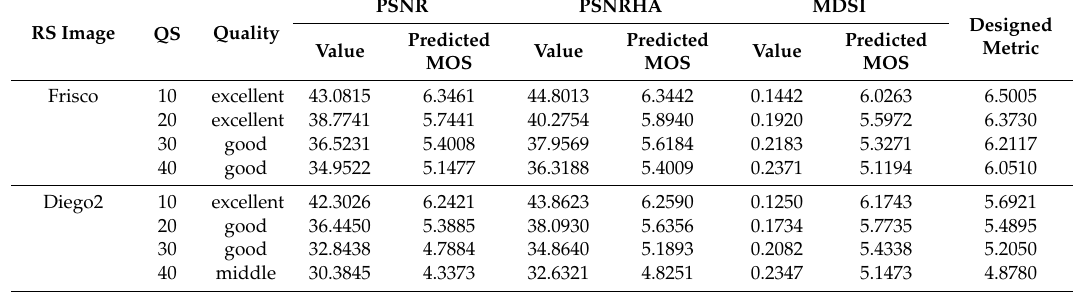
Table 9. Predicted MOS Values for Two RS Test Images Using Linearization.